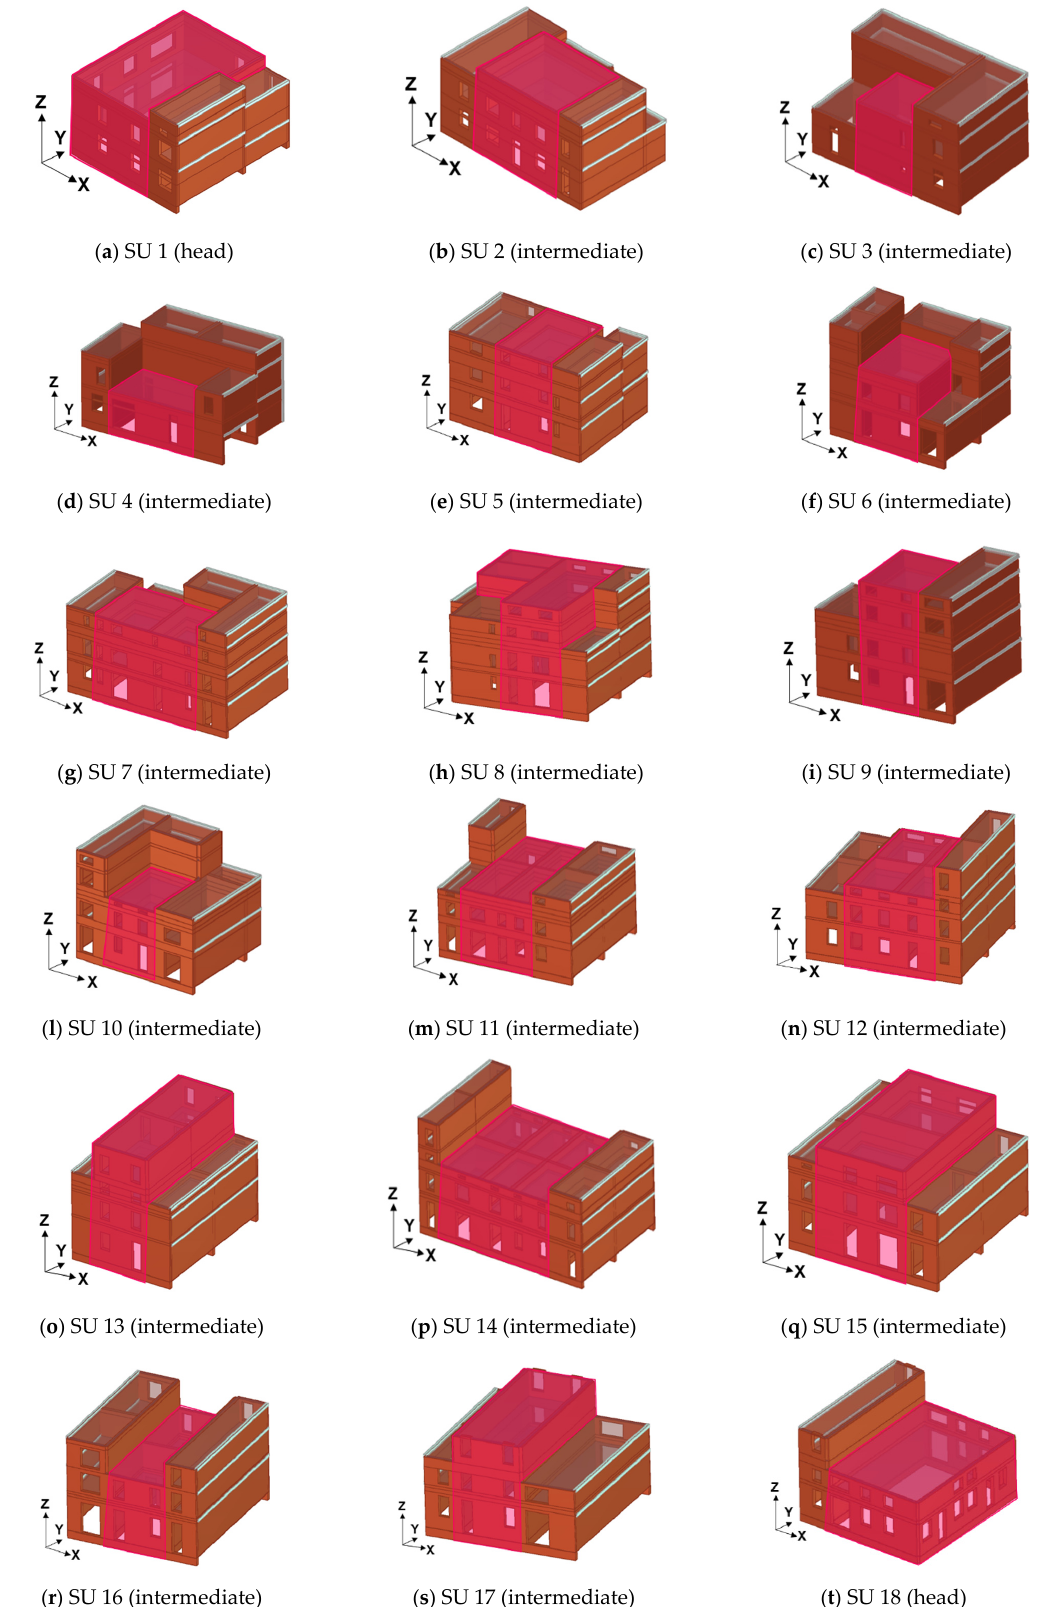
Figure 6. The macro-element models of the investigated SUs in the clustered conditions ( pink ) and the adjacent buildings ( brown ).